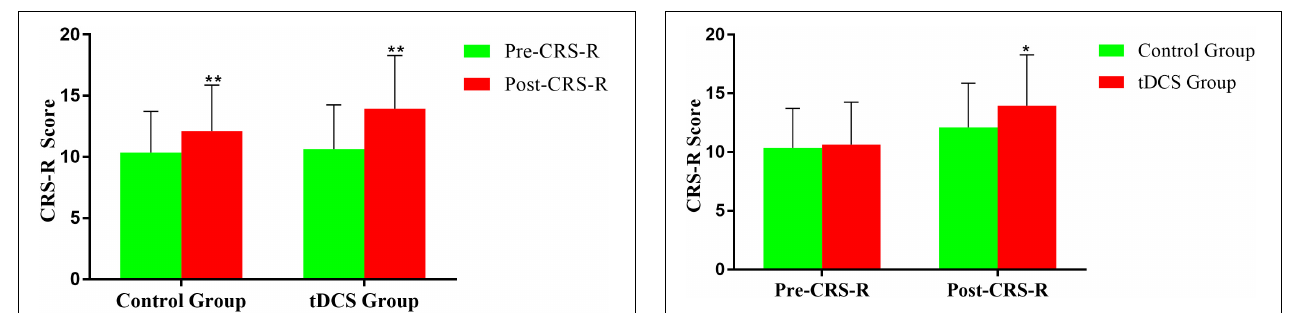
FIGURE 3 | Coma Recovery Scale-Revised (CRS-R) improvement before and after treatment in the groups. ** p < 0.01.